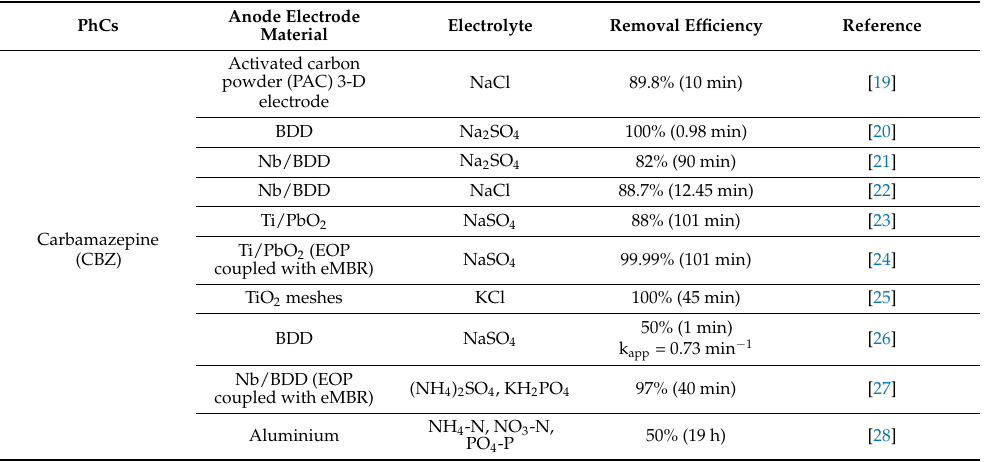
Table 1. Recent publications on electrochemical oxidation processes for the selected PhCs (CBZ, SMX, TCL, DCF, IBU, CFD, CFX).